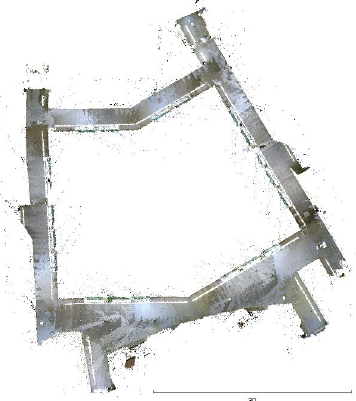
Figure 2. Results of the in-house SLAM algorithm moving the platform along the main corridor of the building level shown in Fig.